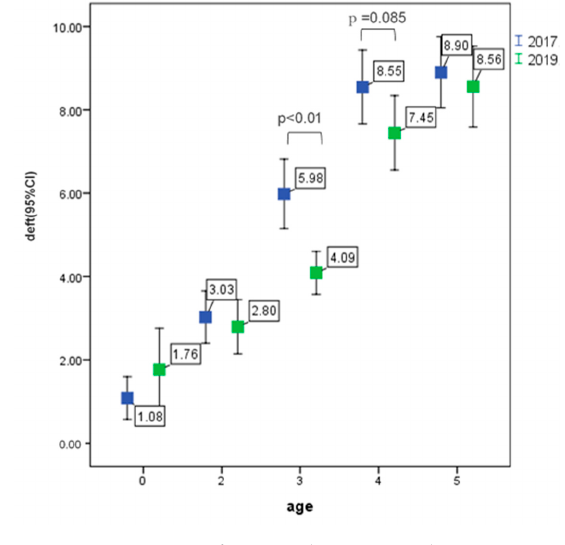
Figure 3. Caries prevalence rate.